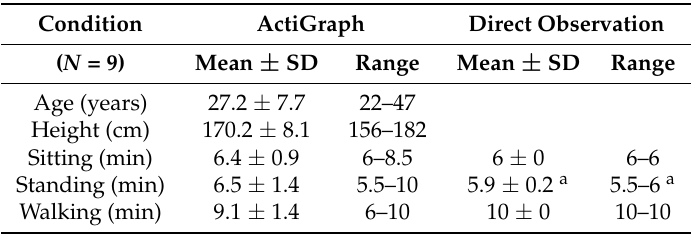
Table 4. Sub-study: Description of population and activity distributions.